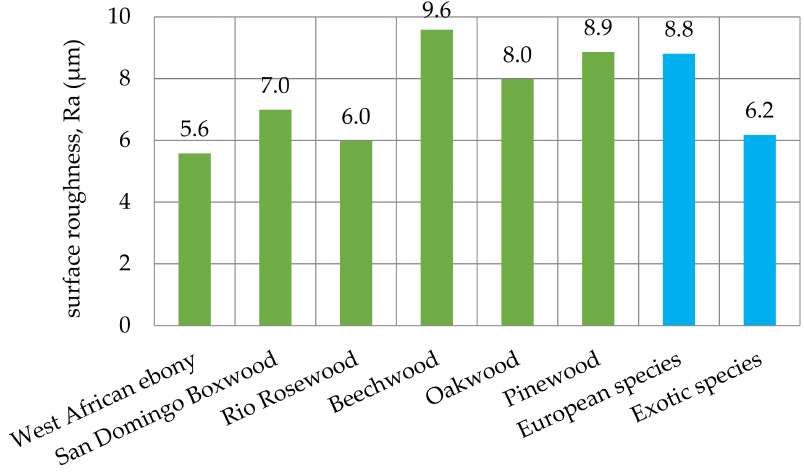
Figure 15. Average surface roughness obtained in all tests depending on the wood